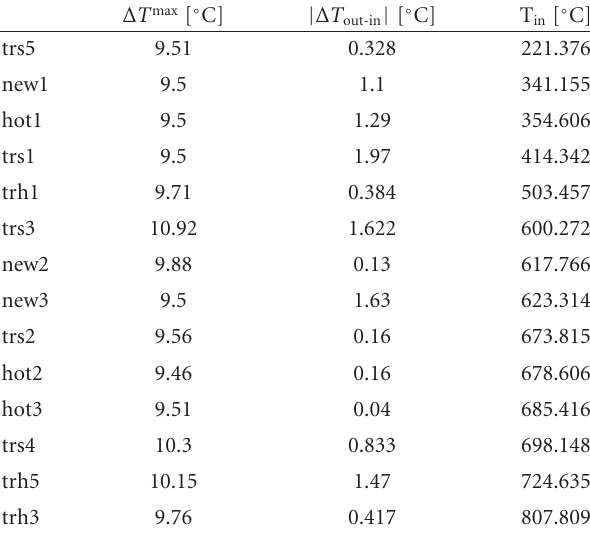
Table 1: Parameters for SC